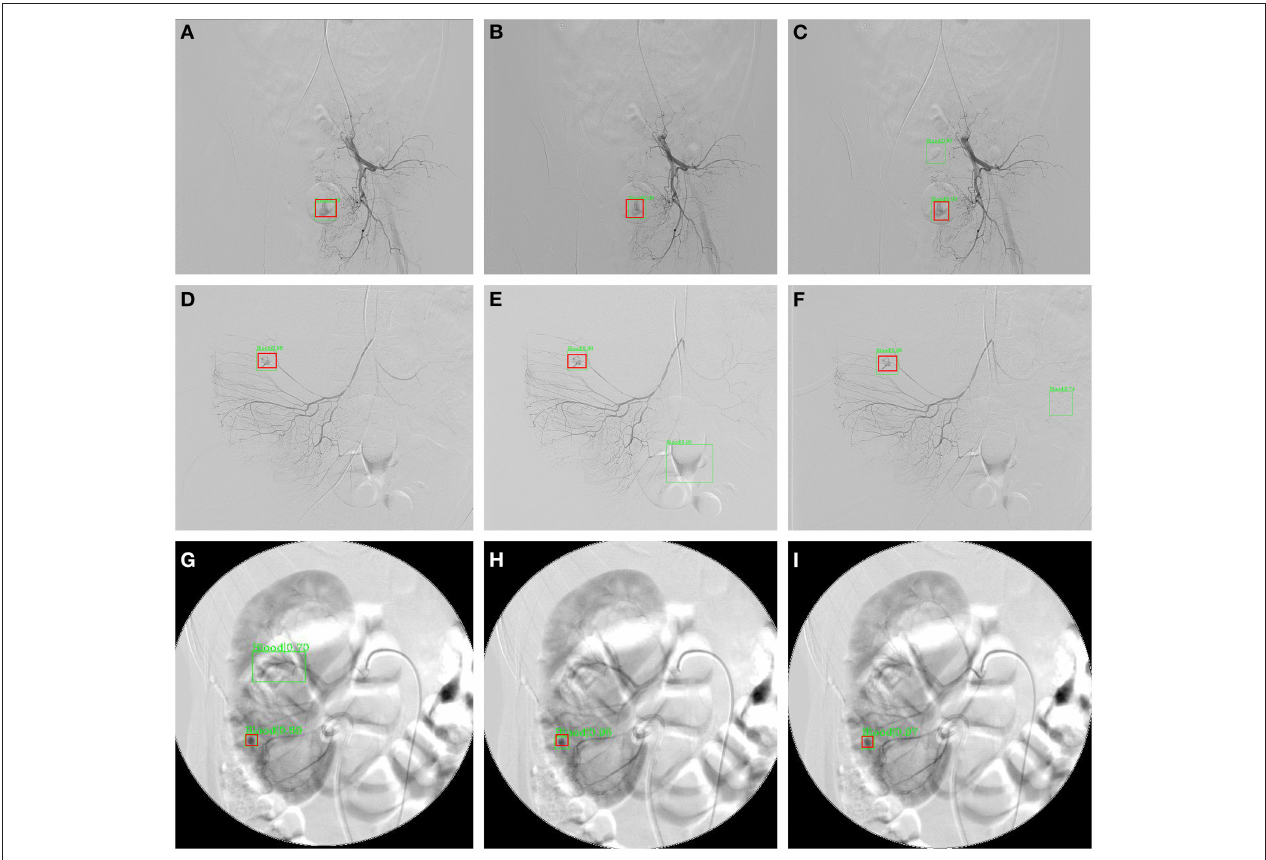
FIGURE 6 | Three sample results from InterNet. (A–C) Are images from a patient with subrectal arterial branch bleeding; (D–F) are images from a patient with bleeding from a right colonic artery branch; (G–I) are images from a patient with a bleeding branch of the inferior artery of the right kidney. The red boxes represent the ground truth bleeding bounding boxes; the green box represents the detected bleeding bounding